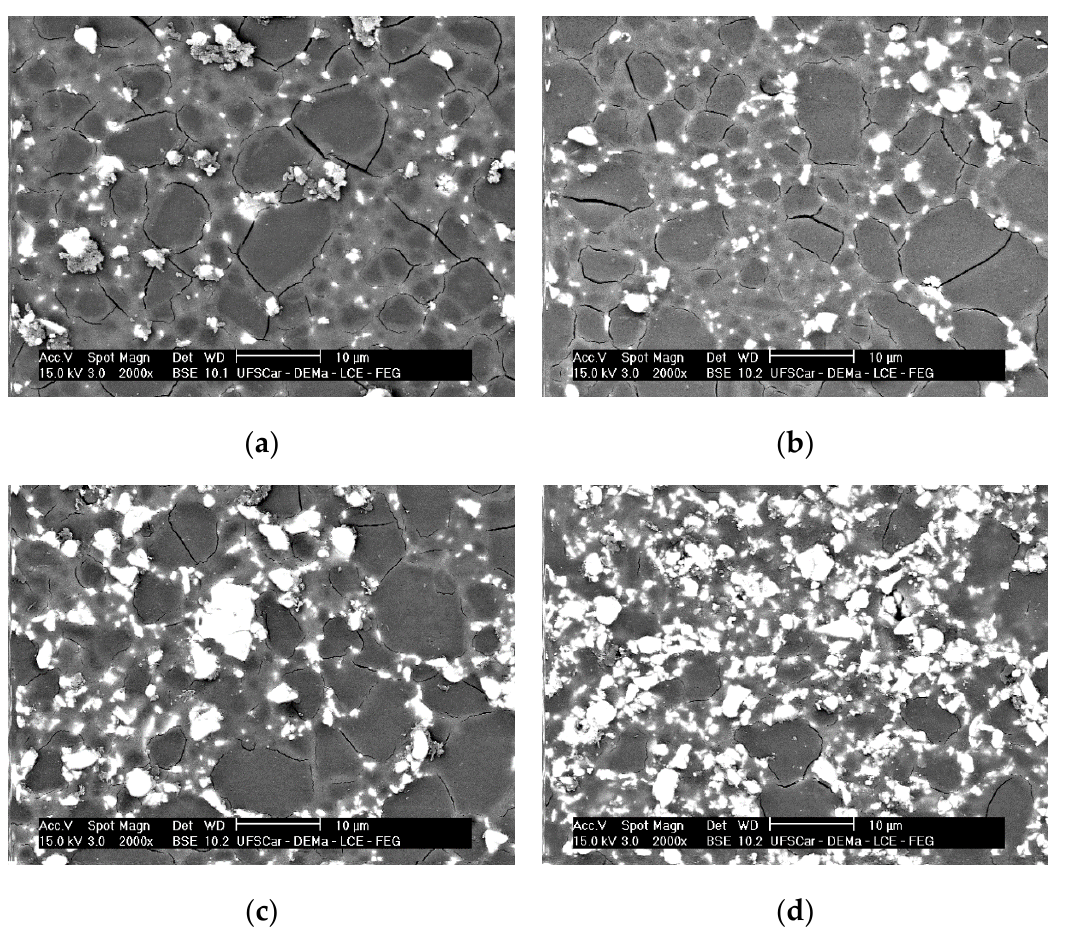
Figure 7. SEM images of polished surfaces of composites after chemical attack in a 70%HF/30%HCl solution. ( a ) LSM5; ( b ) LSM10; ( c ) LSM20; ( d ) LSM30.